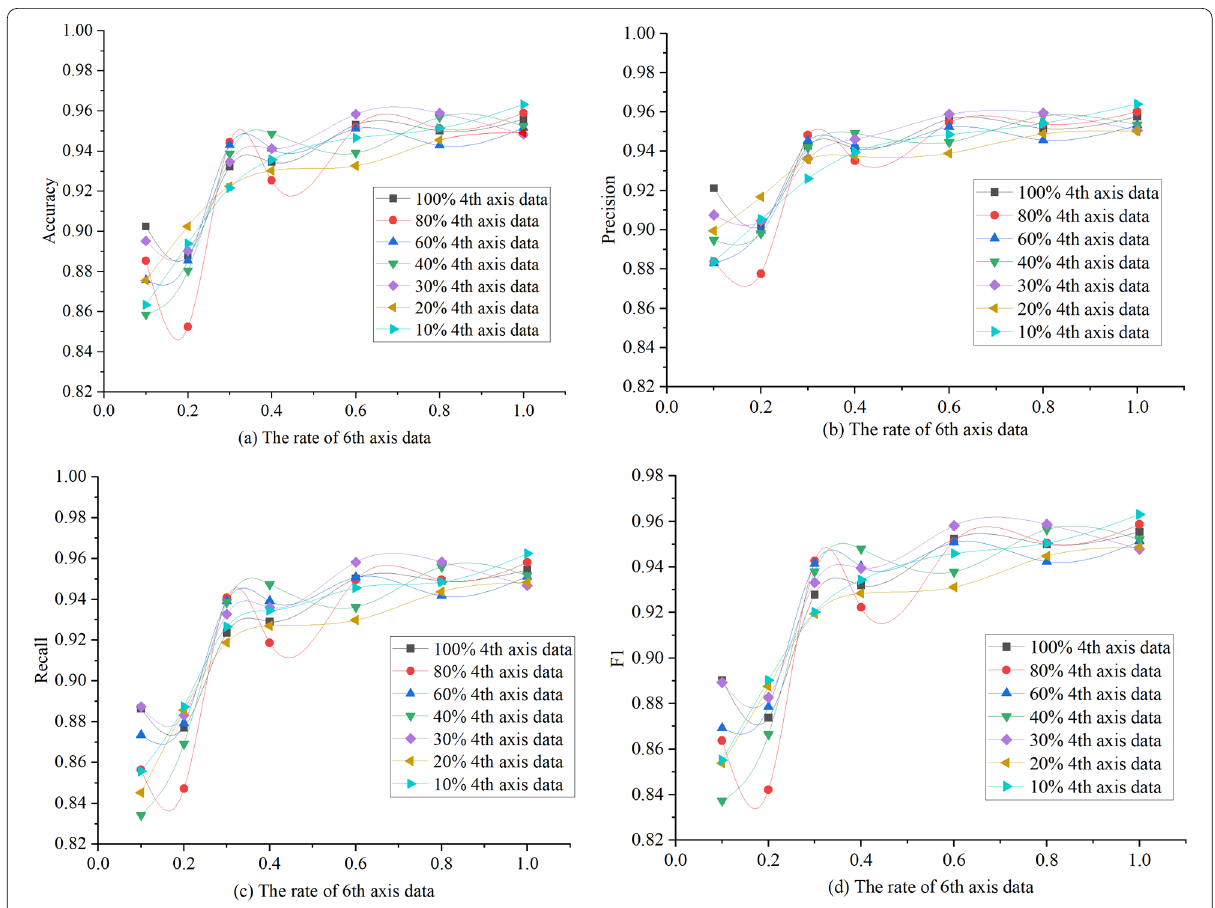
Figure 8 the 4th axis fault diagnosis accuracy under transfer